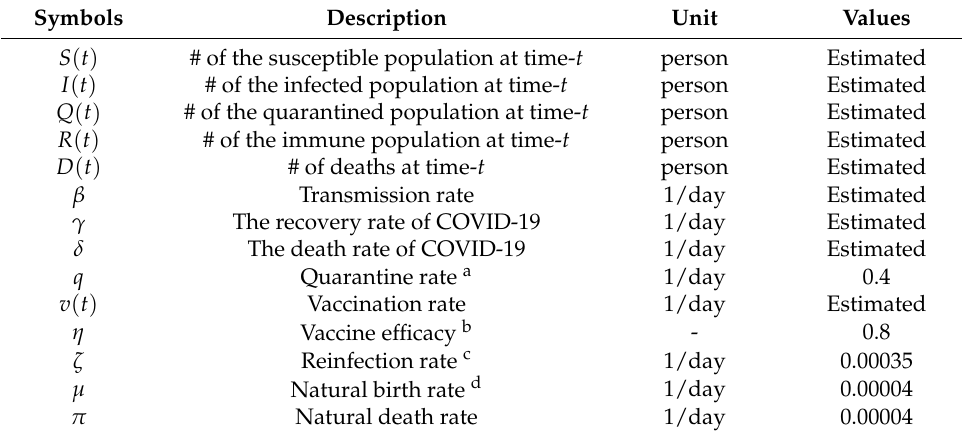
Table A1. Details of variables and parameters used in the SIQRD